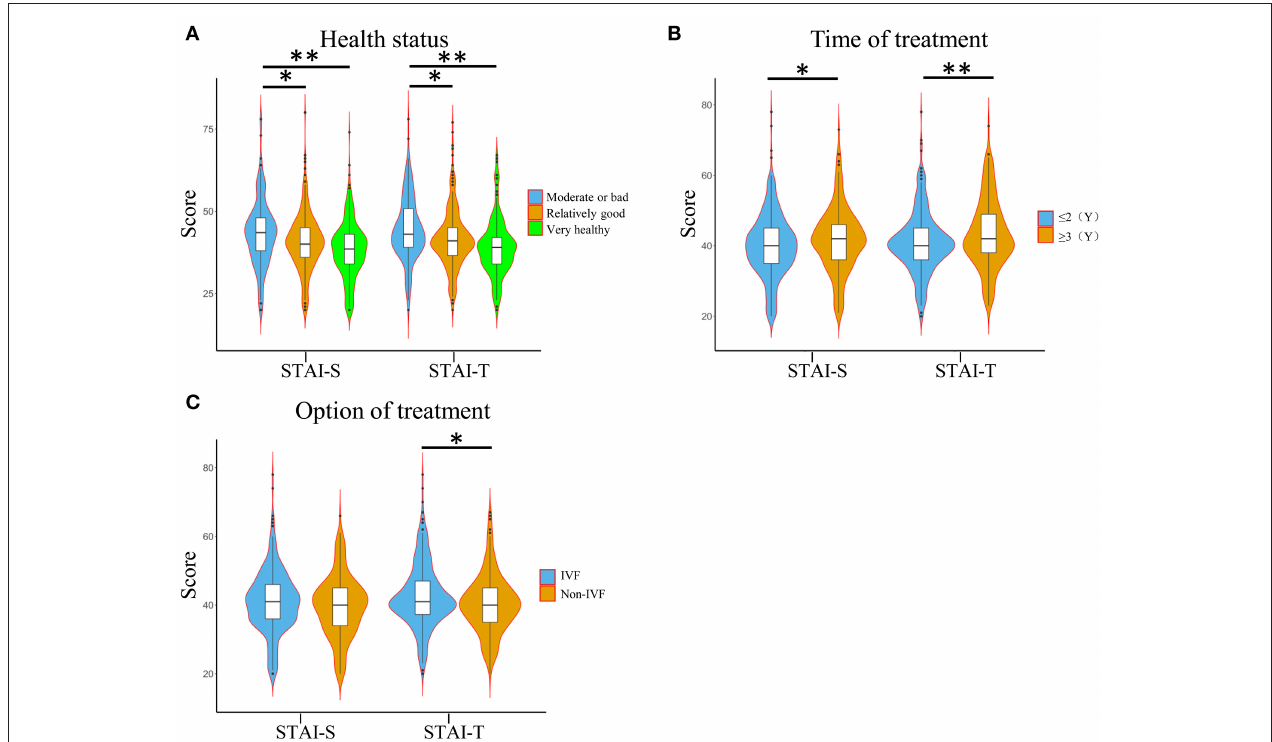
FIGURE 2 | Anxiety score of subgroup level in the included population ( n = 759). (A) The STAI-S and STAI-T score levels in subgroups of different health status. (B) The score levels of STAI-S and STAI-T in the subgroups of different treatment methods. (C) The score levels of STAI-S and STAI-T in the subgroups of different treatment time. STAI-S, State-Trait Anxiety Inventory-State; STAI-T, State-Trait Anxiety Inventory-Trait; IVF, in vitro fertilization. * P < 0.05. ** P < 0.01.